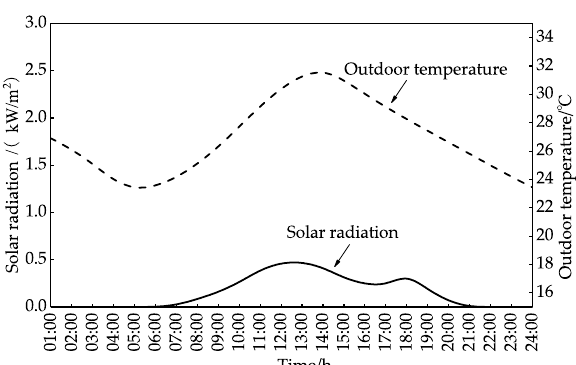
Figure 2. Real-time electricity price.